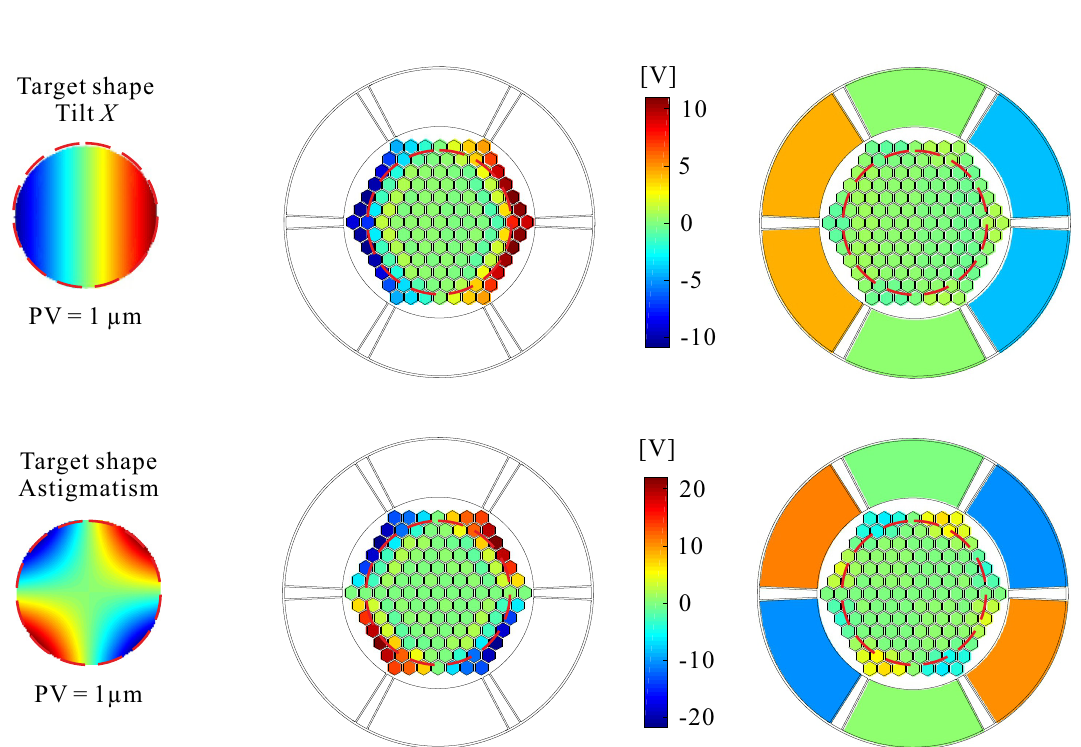
Figure 8. Comparison of the control voltages necessary to achieve a PV = 1 µ m in the pupil. Left: honeycomb actuators alone. Right: honeycomb + front ring actuators. Top: X-Tilt. Bottom: Z5 astigmatism. The voltage ranges and the RMS residual errors are reported in Table